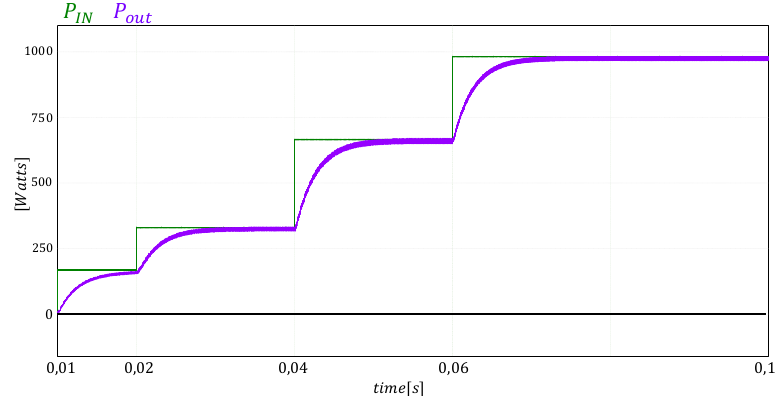
Figure 16. Simulation waveforms. Input power (dark green) and output power (purple).